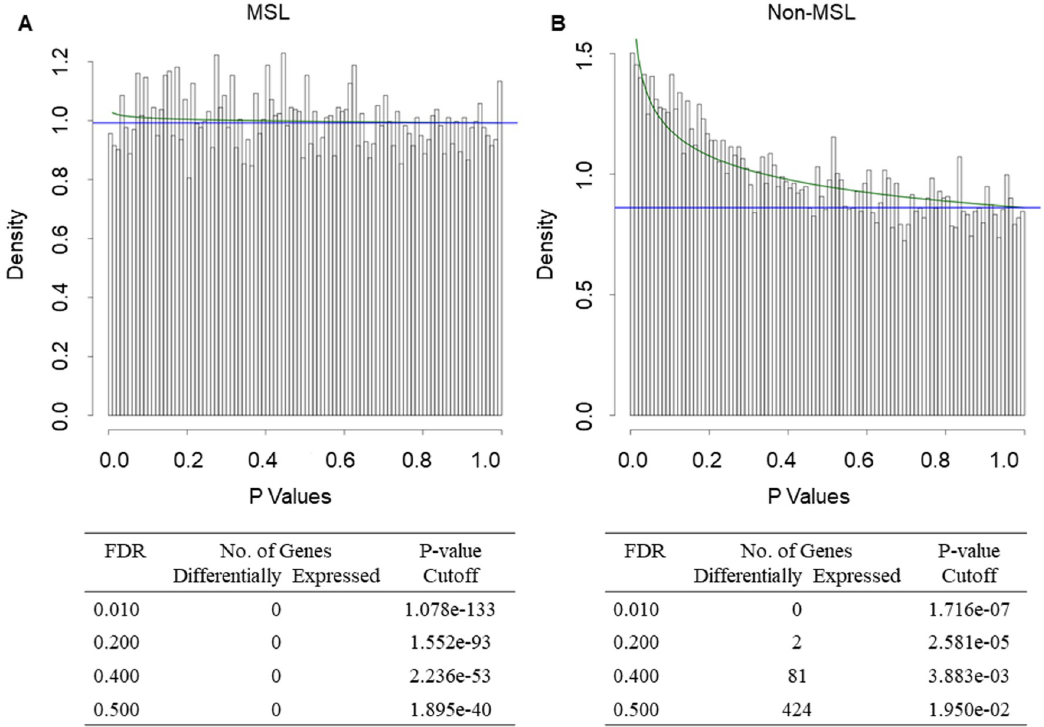
Fig 2. Gene expression in IBC versus non-IBC in (A) 52 patients with non-MSL TNBC and (B) 31 patients with MSL TNBC according to Insight TNBCtype. Top of each panel, Histogram of P values from 2-sample t test for gene expression in TN-IBC versus TN-non-IBC. The overlaid curves are the fitted BUM models. Bottom of each panel, Counts of differentially expressed genes with various FDR cutoffs.